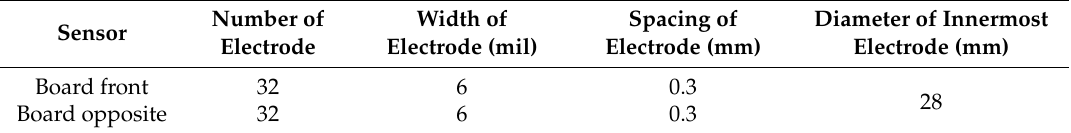
Table 1. Parameters of sensor.